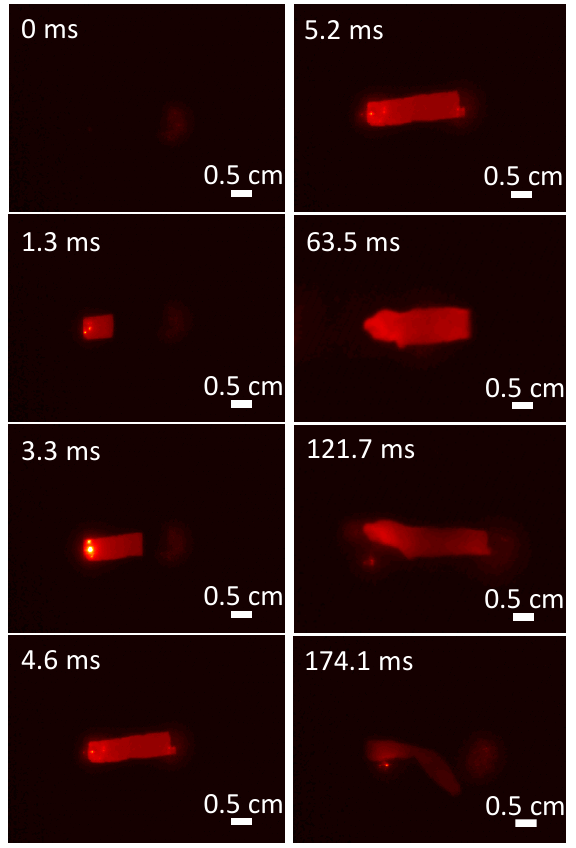
Figure 5. High speed camera measurement of the RMF reaction.